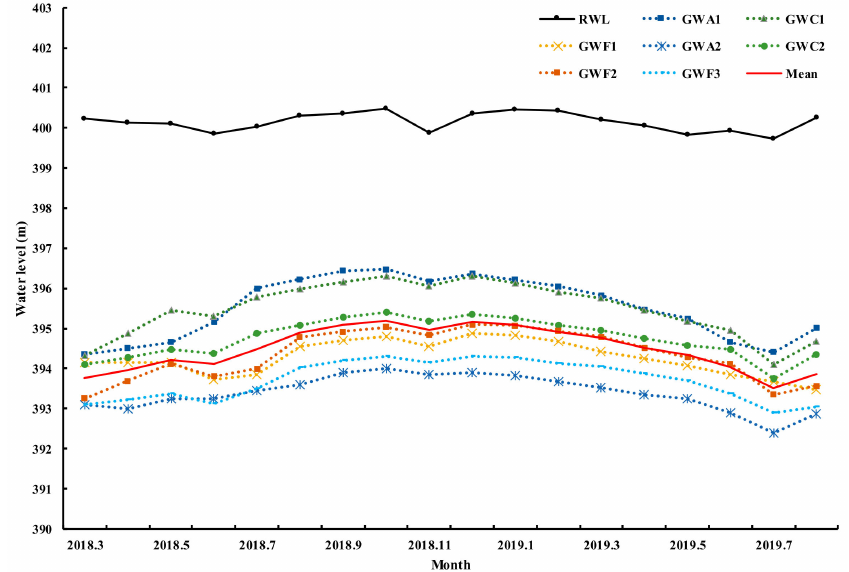
Figure 3. The level changes of reservoir water and